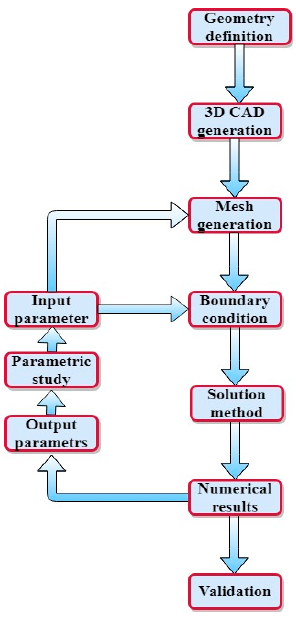
Figure 2. Flowchart of the numerical procedure of this study.